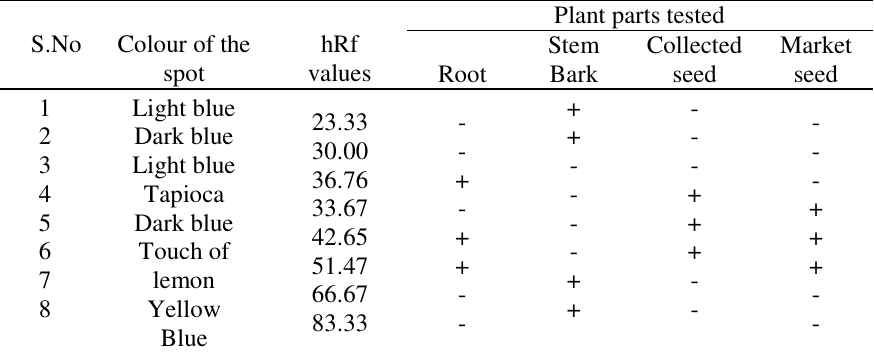
Table 4 . Qualitative separation of flavonoids of S.potatorum